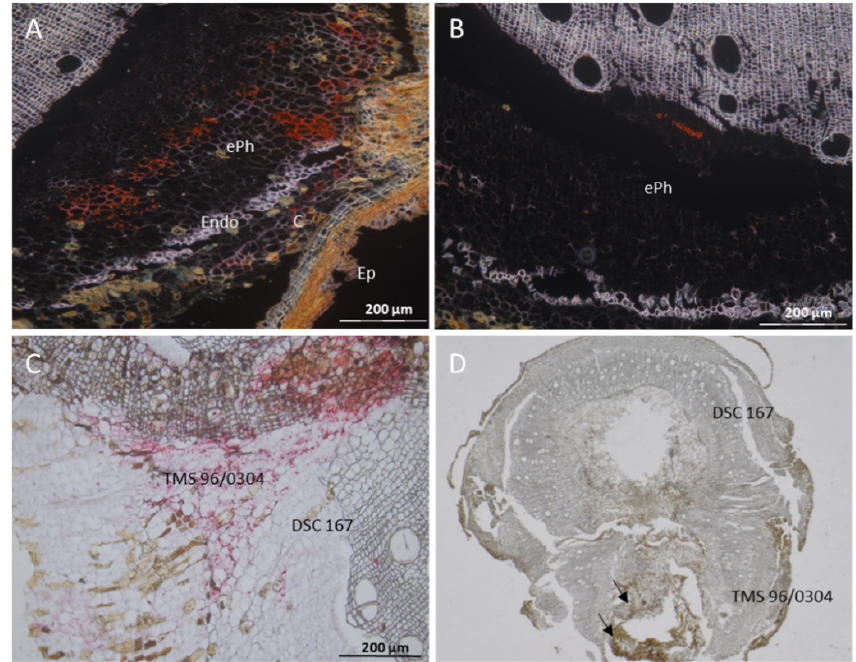
Figure 4. Distribution of CBSV-Mo83 RNA in cassava tissue at a graft intersection of the chimeric plant TMS 96/0304-DSC 167. Cross sections of cassava stem tissue subjected to RNAscope ® ISH using a CBSV-Mo83 probe show red signals indicating the presence of the viral RNA. ( A ) Virus presence in phloem and non-phloem cells of TMS 96/0304. ( B ) Virus found only in the external phloem of DSC 167. ( C ) Cross section through the graft intersection with red signals scattered throughout TMS 96/0304 portion and rarely found in DSC 167. ( D ) Anatomy of the cassava graft intersection in the chimeric TMS 96/0304-DSC 167. Arrows point to necrotized tissues. C, cortex; ePh, external phloem; iPh, inner phloem; Ep, epidermis; Endo, endodermis.